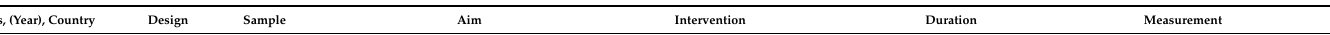
Baseline Energy(kcal)